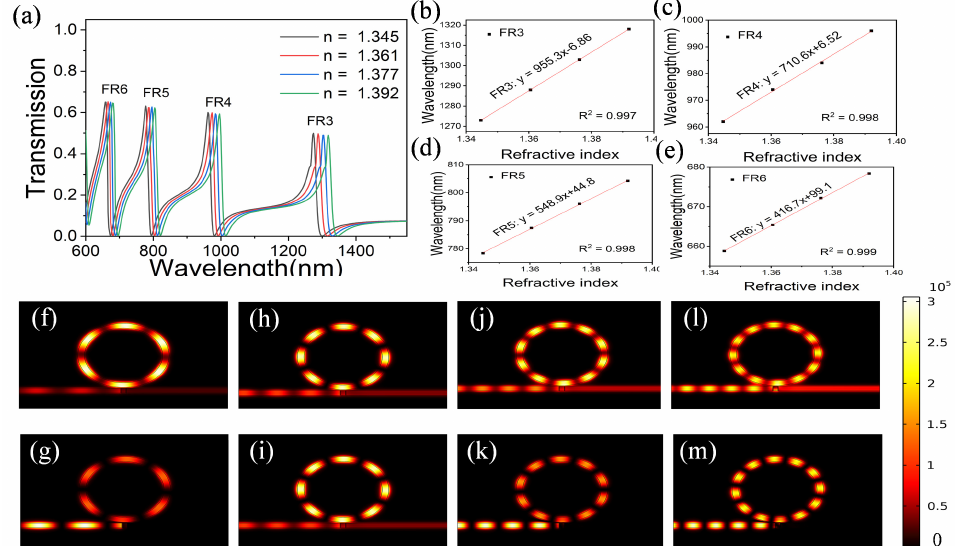
Figure 3. ( a ) Transmittance spectra of the optimized structure for different refractive indices of MUS, n = 1.345 to 1.392. Relationships between the resonance wavelengths of ( b ) FR3, ( c ) FR4, ( d ) FR5, 2 distribution of the peak and valley wavelength in transmittance ( e ) FR6, and refractive index. Hz | | spectra when T = 60 ◦ C, ( f ) FR3, λ peak = 1274 nm; ( g ) FR3, λ valley = 1300 nm; ( h ) FR4, λ peak = 962 nm; ( i ) FR4, λ valley = 981 nm; ( j ) FR5, λ peak =778 nm; ( k ) FR6, λ valley = 794 nm; ( l ) FR6, λ peak = 659 nm; ( m ) FR6, λ valley = 674 nm.